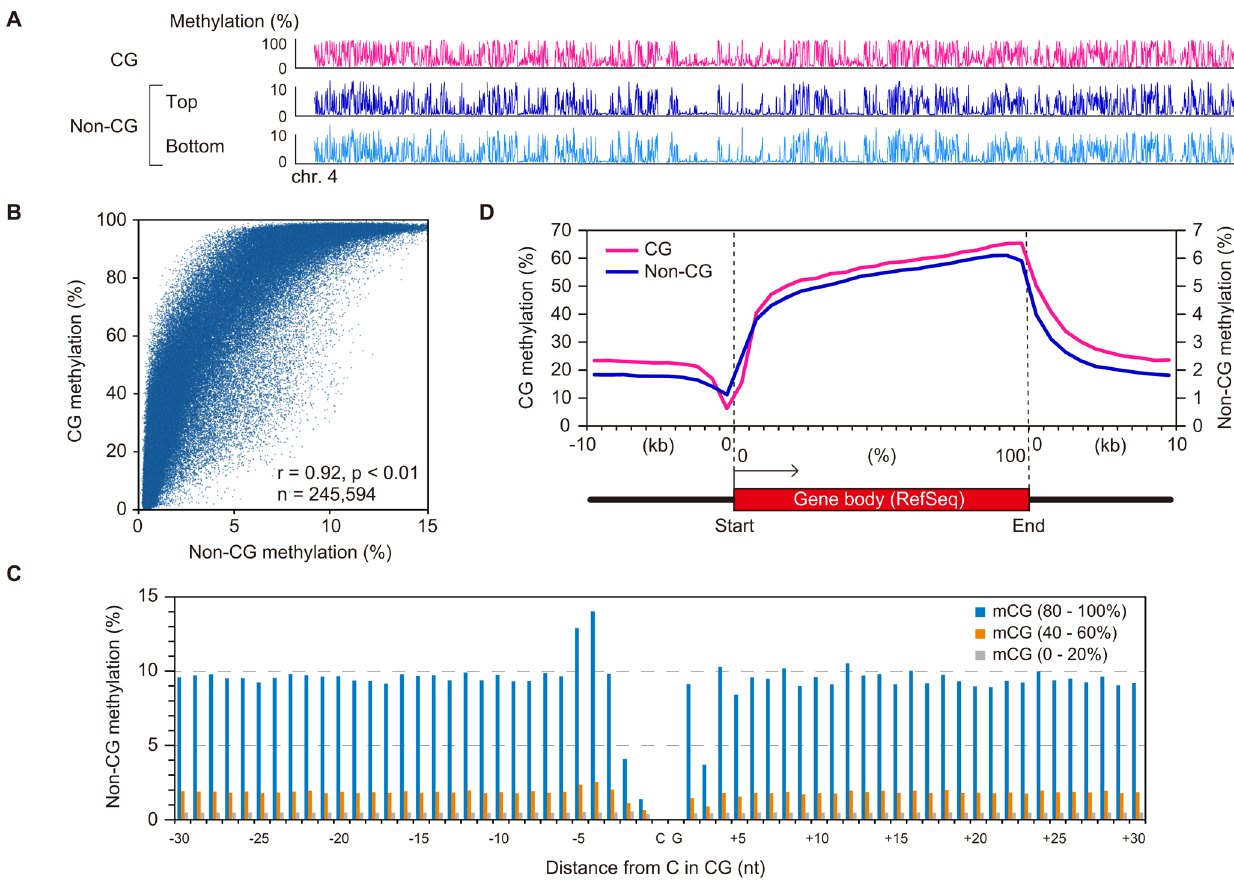
Figure 2. Relationship between CG methylation and non-CG methylation in GVOs. (A) Levels of CG methylation and non-CG methylation across the entire chromosome 4 in a non-overlapping sliding window of 50 kb. The two strands were separately analyzed for non-CG methylation. (B) Correlation between the levels of CG methylation and non-CG methylation in 10-kb non-overlapping sliding windows across the genome was indicated using Spearman’s rank correlation coefficient. (C) Effect of CG on non-CG methylation at positions immediately upstream and downstream of mC sites. Blue, orange, and gray bars indicate the levels of non-CG methylation around CG sites with at least 10 6 coverage with methylation levels of 80–100%, 40–60%, and 0–20%, respectively. (D) Levels of CG methylation and non-CG methylation relative to gene structure. The upstream and downstream regions (10-kb each) were split into 10 non-overlapping windows to determine the methylation levels. The intragenic or coding regions were divided into 20 small windows for methylation analysis.